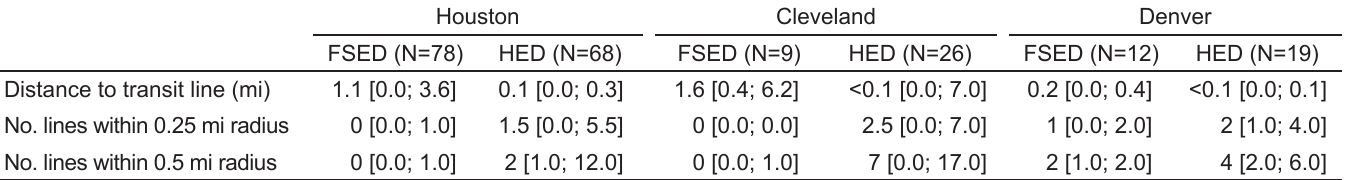
Table 1. Proximity of freestanding emergency departments and hospital emergency departments to public transit lines.